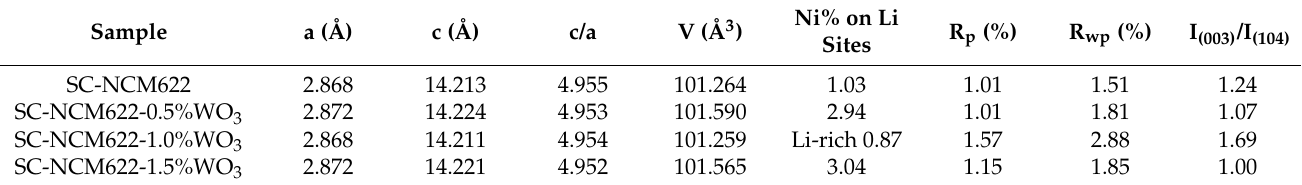
Table 1. Crystallographic data from Rietveld refinement for prepared LiNi 0.6 Co 0.2 Mn 0.2 O 2 with- out/with WO 3 modification.